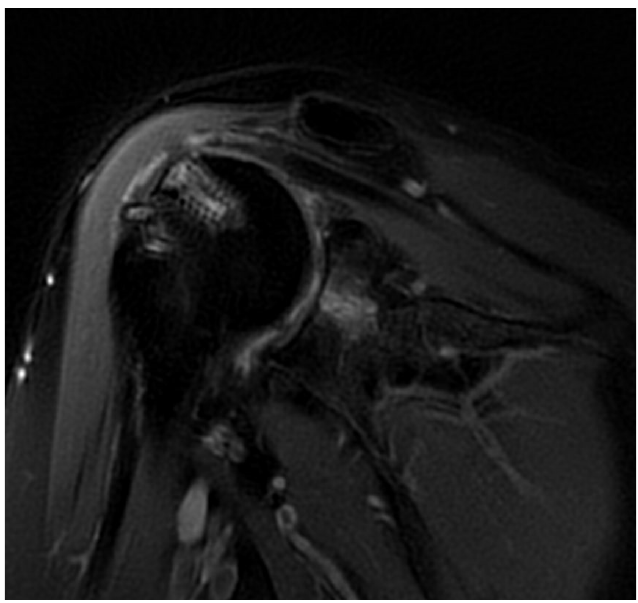
Figure 1. T2-weighted sagittal MRI of a shoulder following successful healing of a supraspinatus tear with DBM, PRP, and cBMA augmentation. There were no differences between the success and failure groups for age, gender, body mass index (BMI), or diabetes status (Table 1). There were no patients with rheumatologic conditions or a history of cancer. There were no statistically significant differences between groups on handedness, surgical side, Patte Classification (tendon retraction), Goutallier Stage (fatty infiltration), history of prior shoulder surgery of any type, or history of prior rotator cuff repair (Table 1). Of the 10 non-failure patients, 1 had an acute tear while 9 were chronic. All the failed patients had chronic tears. Biceps tenodesis was performed concomitantly with the DBM repair in 10% of the non-failure group and 80% of the failure group, which was significantly different. Subacromial decompression was performed in 20% of non-failure patients and 30% of failure patients, which was not significantly different (Table